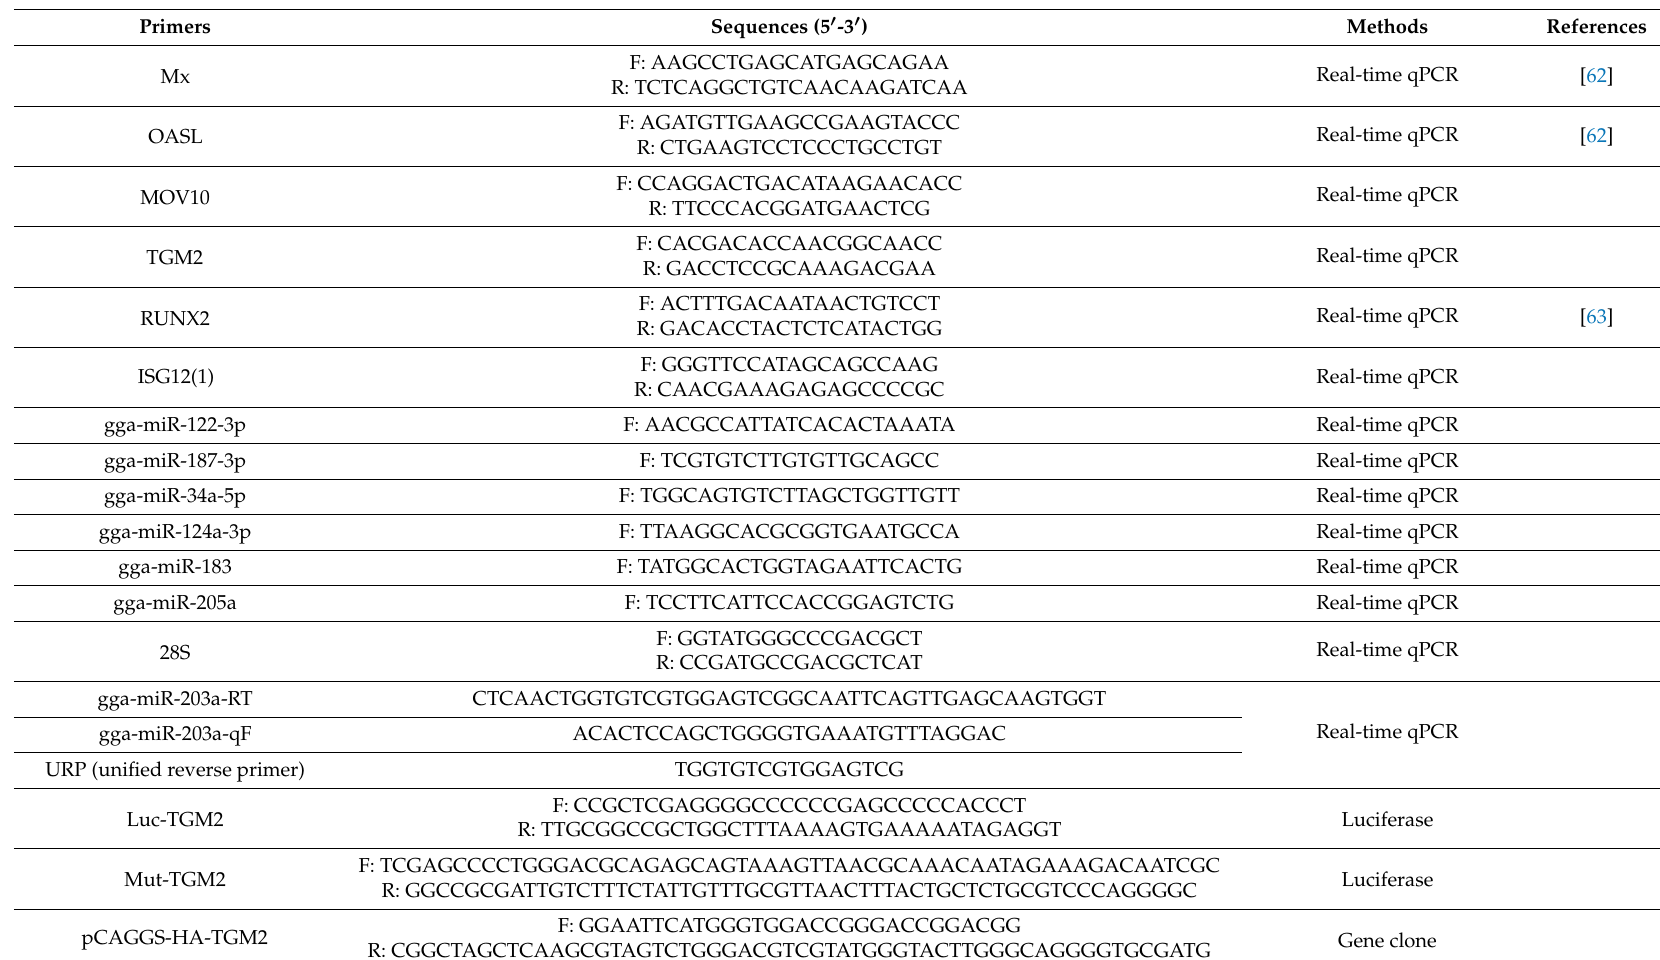
Table 1. Primers used in this